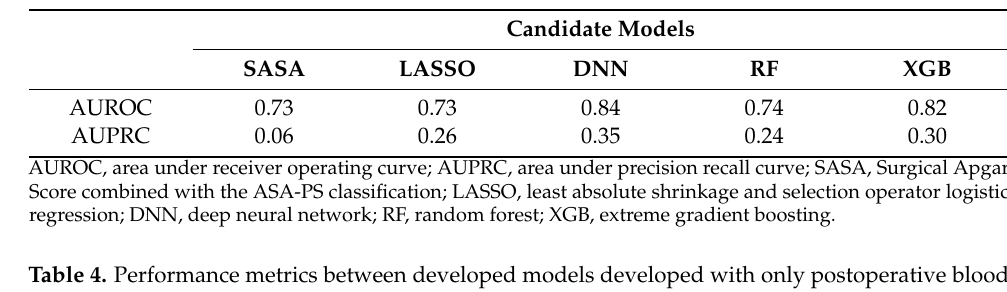
Table 3. Performance metrics between SASA scoring system and other machine learning-based models using VitalDB.